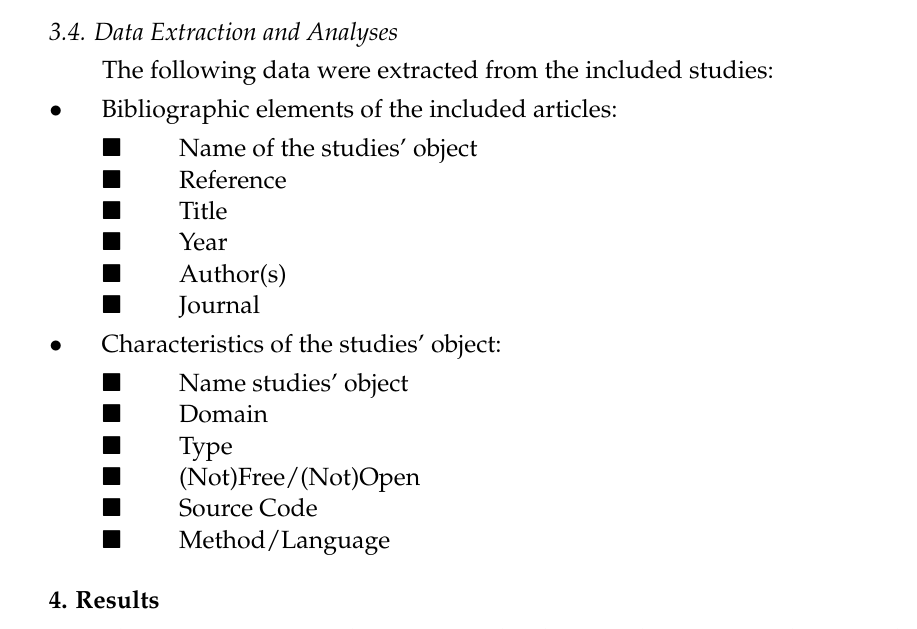
Figure 1. The flow diagram of the literature search.